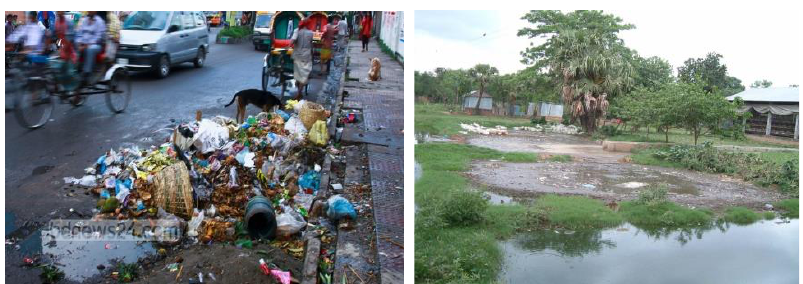
Figure 4. Roadside waste dumping in Dhaka ( left ) and dumping of poultry litter adjacent to water courses ( right ) [31]. (Reproduced with permission from Gofran, 2009).